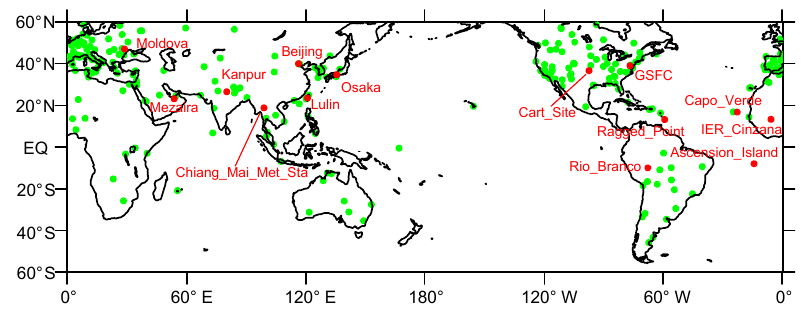
Figure 3. AERONET sites used in this study. Red circles denote the AERONET sites used in Fig.